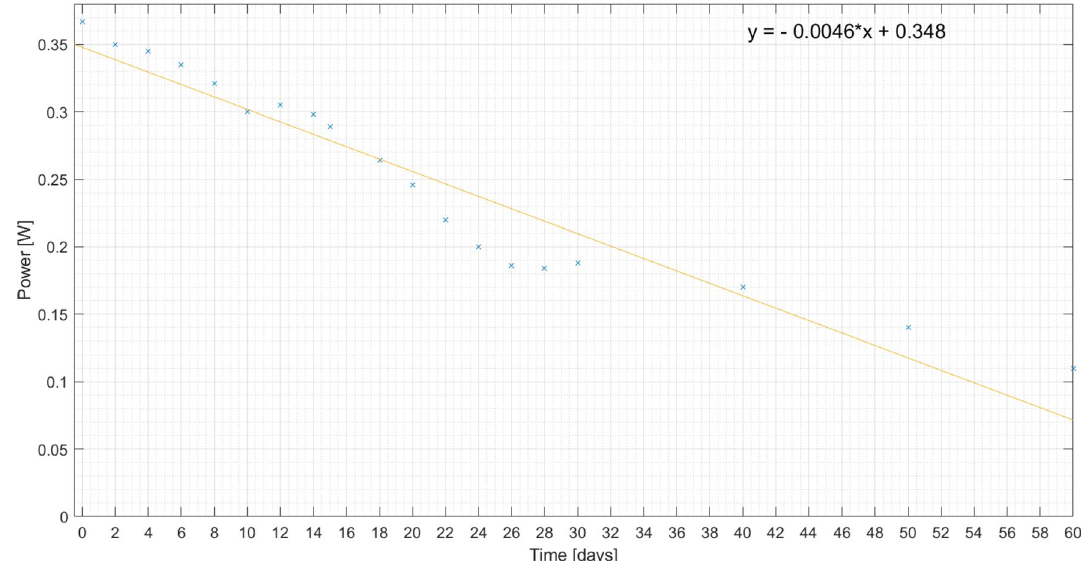
Figure 22. Measured output power on pure aluminium plate (plates 1 and 2) for 60 days and respective linear regression.